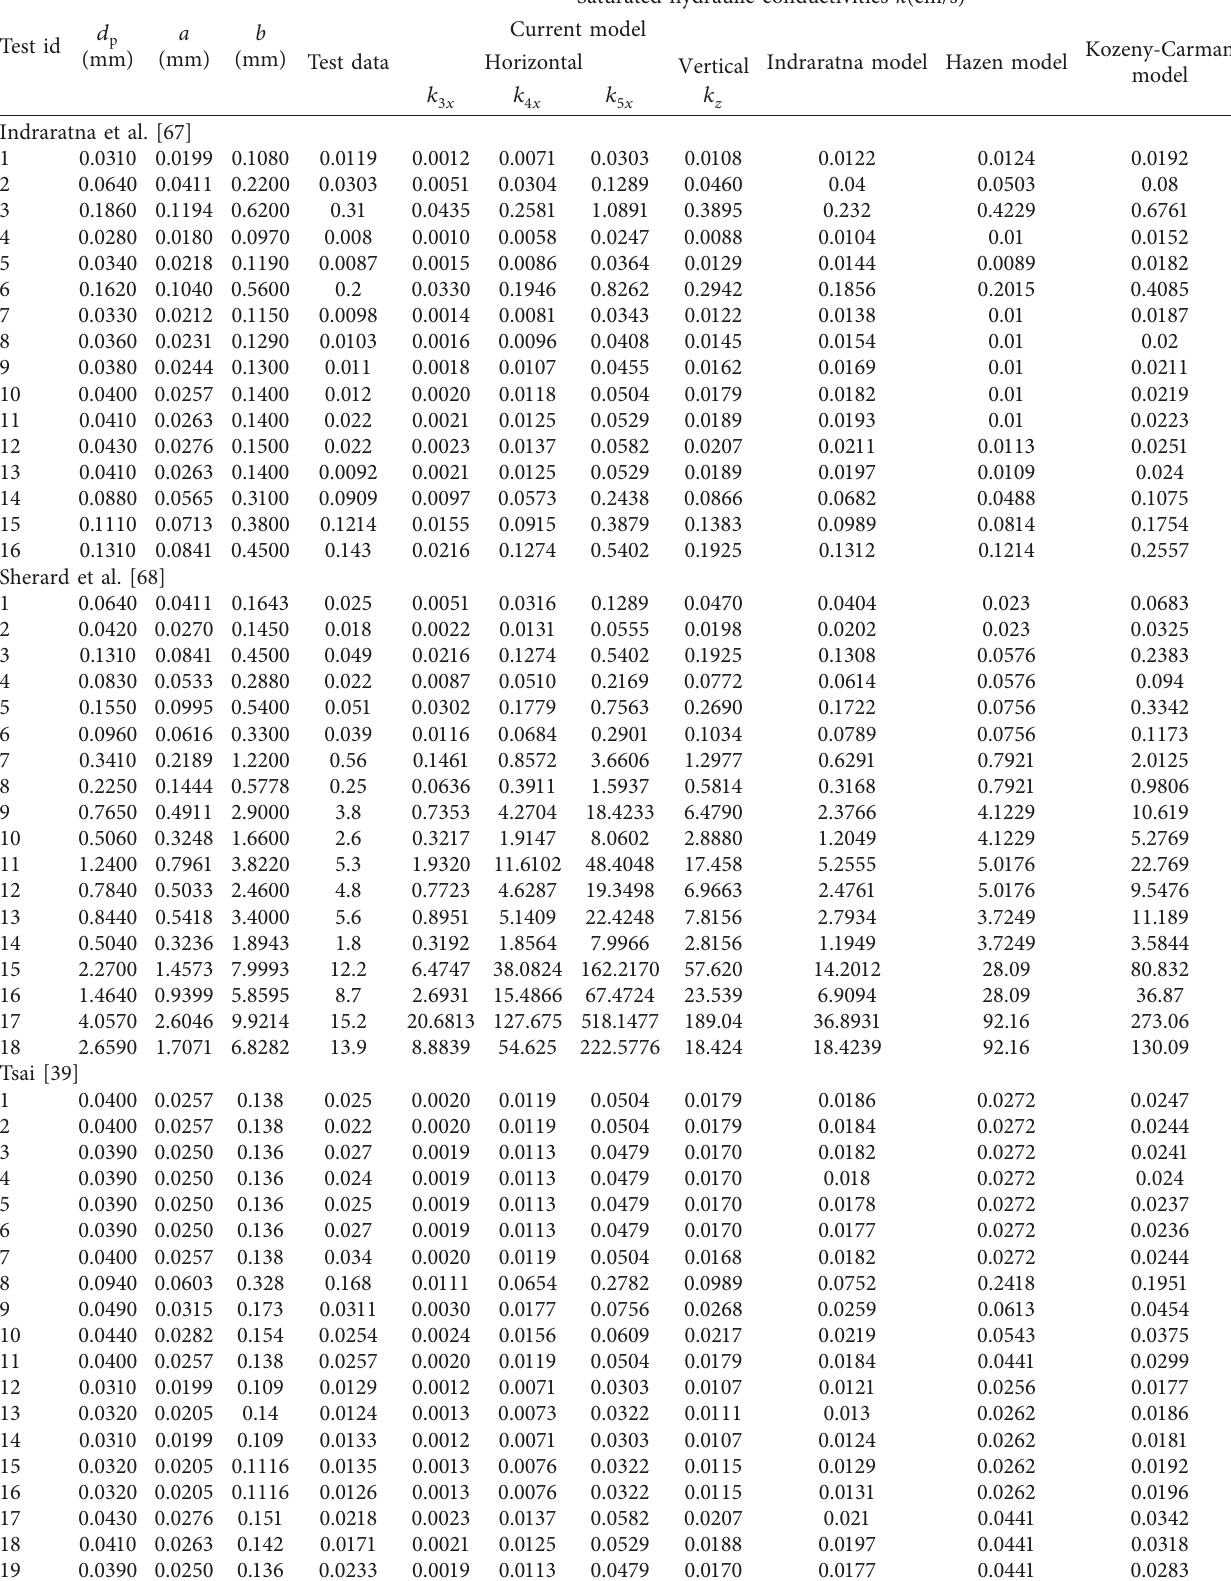
Table 3: Computed sizes of particles and corresponding values of saturated hydraulic